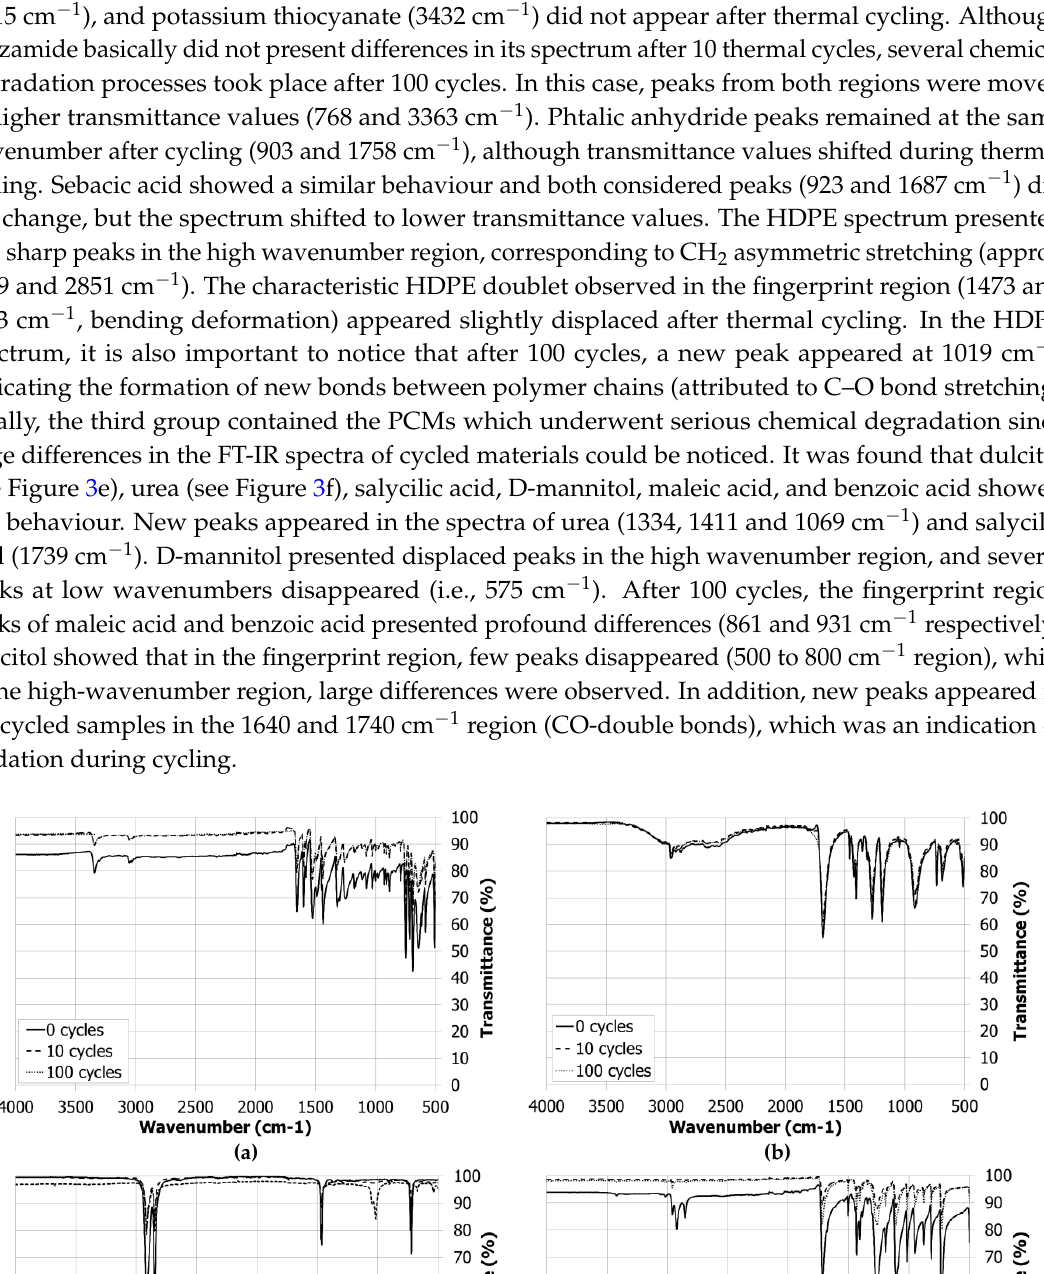
(f) Figure 3. FT-IR spectroscopy results: ( a ) Adipic acid; ( b ) Benzanilide; ( c ) HDPE; ( d ) Dimethyl terephthalate; ( e ) Dulcitol; ( f ) Urea. 5. General Discussion Taking into account the thermophysical characterization from the cycling stability tests results, only dimethyl terephthalate, benzanilide, potassium thiocyanate, HDPE, benzamide, phtalic anhydride, and adipic acid showed a suitable stability after 100 cycles. However, benzamide and benzanilide presented remarkable differences between solidification and melting temperatures at the laboratory scale. Therefore, these two candidates might be interesting to be tested at a higher scale to study this phenomenon since the differences between solidification and melting temperatures and subcooling of PCM are mass dependent [17]. From this first filter, and taking into account the chemical characterization, it was seen that adipic acid showed the same chemical spectrum after cycling tests, while HDPE, potassium thiocyanate, and dimethyl terephthalate did not exhibit important chemical degradation but rather the appearance or disappearance of some peaks. Moreover, from the health hazard point of view, potassium thiocynate should be disregarded due to its high hazard value according to the methodology explained. Adipic acid and dimethyl